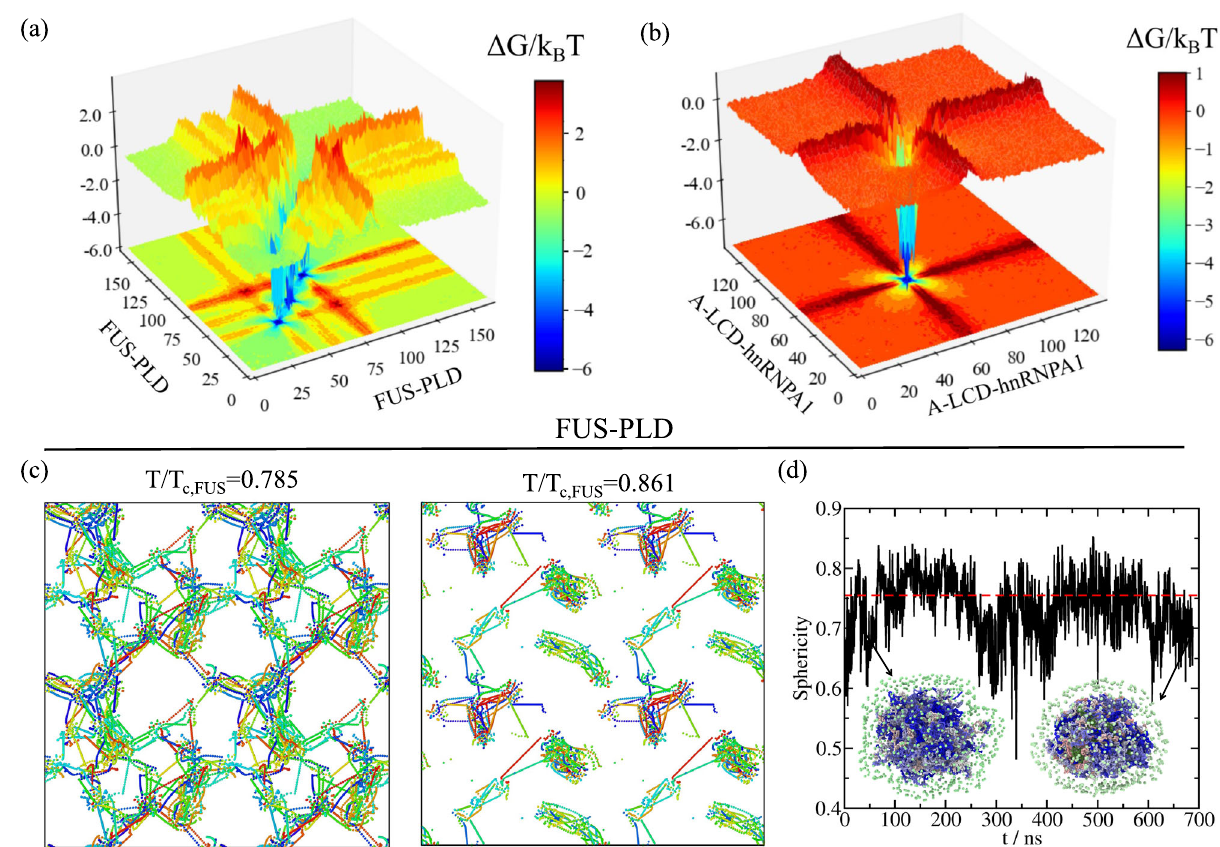
Fig. 3 | Imbalanced protein binding can drive condensate ageing but not dro- inter-peptide β -sheet motifs was ~75% along the trajectory. The horizontal red plet reshaping. Landscape of the protein contact free energy variation upon dashedline representsthe averagesphericityforaFUS-PLDcondensateinaliquid- like state (reference model). Two representative con fi gurations of the condensate condensateageingforbulkFUS-PLDcondensatesat T / T c,FUS =0.785( a )andA-LCD- surrounded by the surface map (light green) are provided with LARKS residues hnRNPA1 condensates T =0.97 T c ( b ). Δ G / k B T is obtained from the residue contact belonging to inter-peptide β -sheet clusters depicted in dark green and fully dis- probability ratio between aged condensates and liquid-like condensates before order residues belonging to distinct protein replicas depicted by a blue-to-grey ageing. Colour map projections of the free energy landscape in 2-dimensions are colour range. Details on the sphericity parameter evaluated through a Solvent also included. c Network connectivity of aged FUS-PLD condensates at T / T T / T Available Surface Area (SASA) analysis as well as of the primitive path analysis and c,FUS =0.785 (Left) and c,FUS =0.861 (Right) computed using a primitive path analysis. d Evolution of droplet sphericity during condensate ageing at the protein contact free energy calculations are provided in the Supplementary T / T c,FUS =0.81.ThepercentageoftransitionedfullydisorderLARKSintostructured